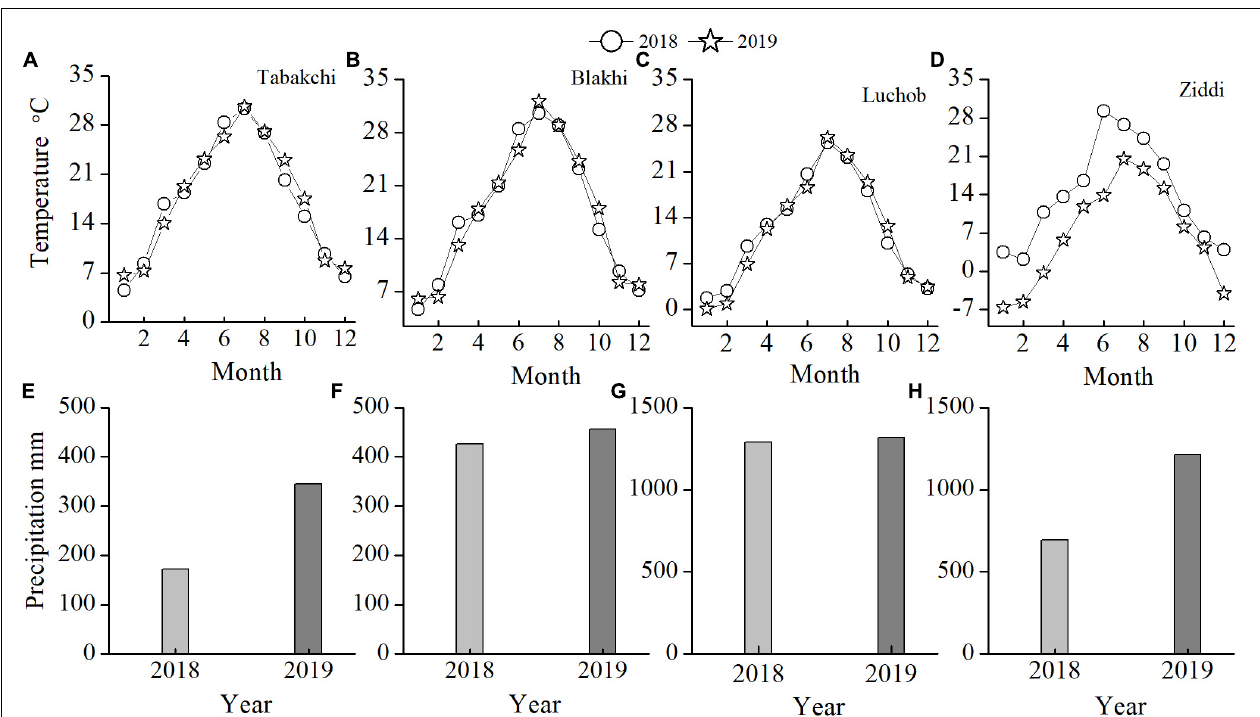
FIGURE 2 | The average monthly temperature (A–G) and monthly precipitation (E–H) in the four experimental sites.